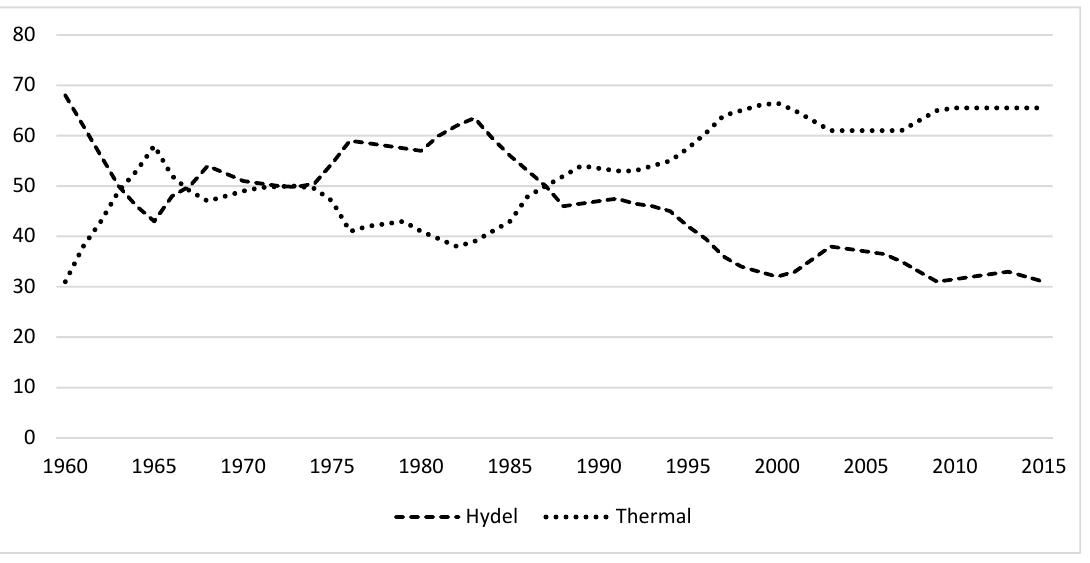
Figure 9. Decreased share of hydel in electricity generation from 1960–2015 in percentage.